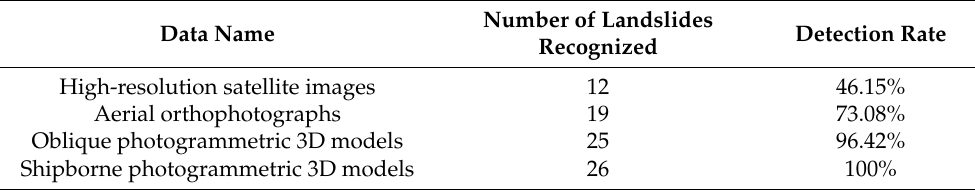
Table 5. Landslide detection results of different remote sensing